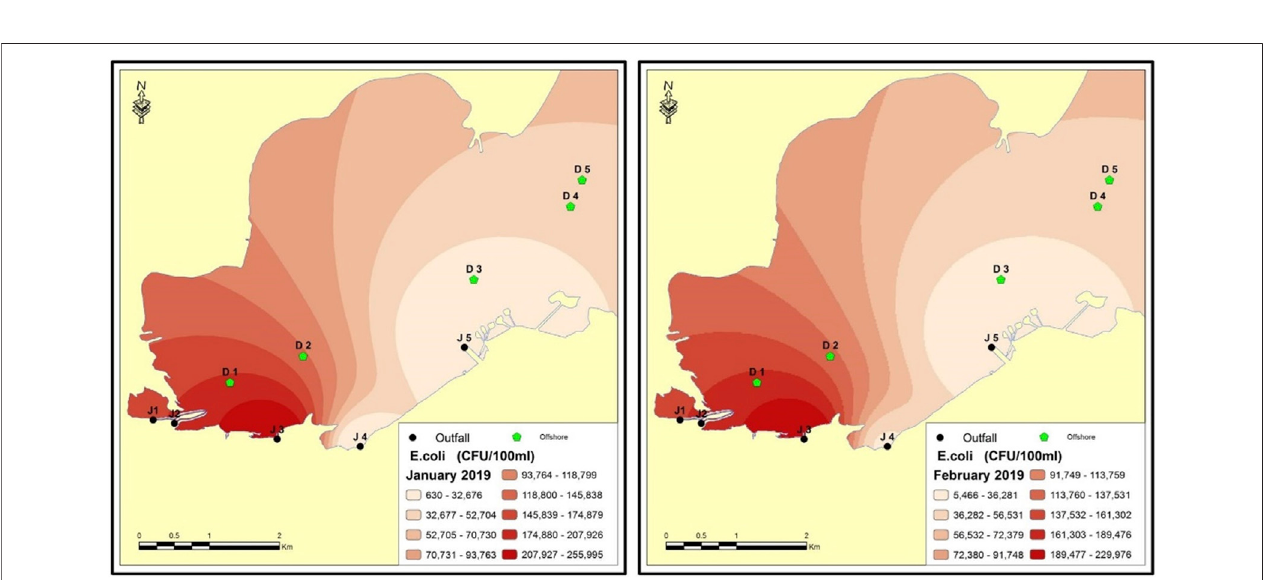
FIGURE 7 | Distribution of E. coli in Doha Bay using